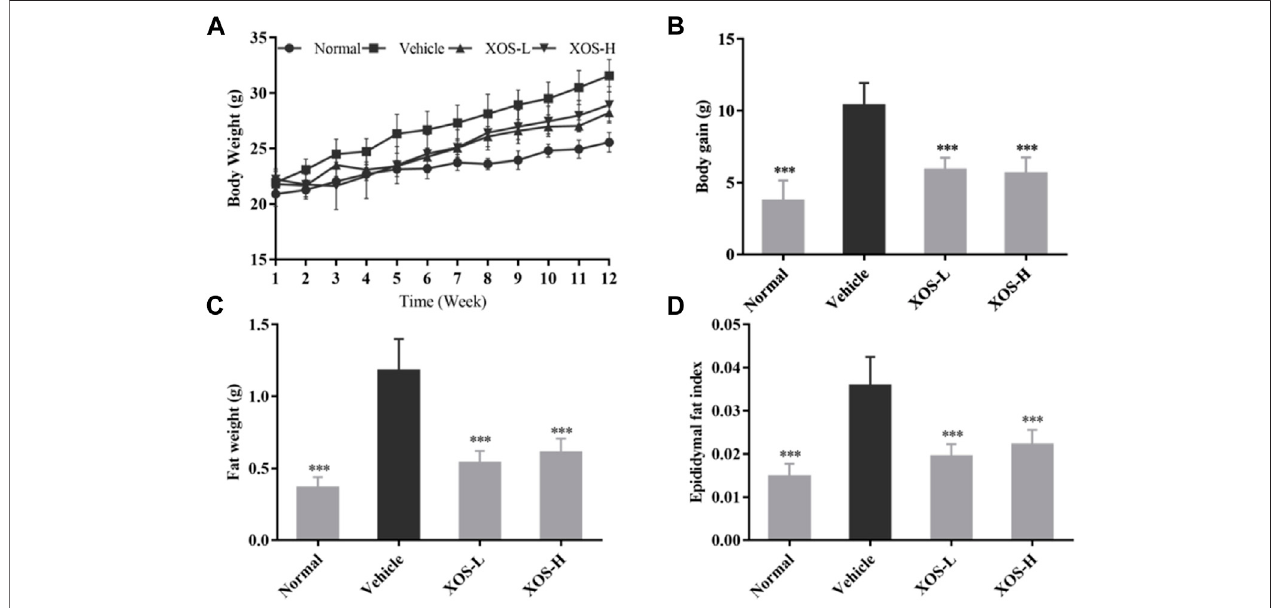
FIGURE 1 | Effect of XOS supplementation on (A) Body weight curve; (B) weight gain; (C) Epididymal fat weight; (D) Epididymal fat index. XOS-L: mice treat with XOS 250 mg/kg, XOS-H: mice treat with XOS 500 mg/kg. *** p < 0.001 compared with the Vehicle group.